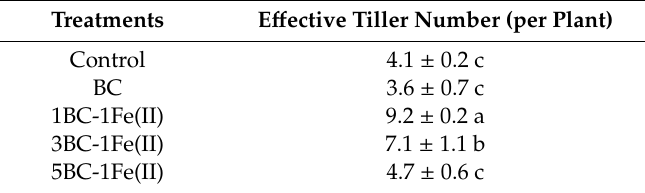
Figure 1. Growth of rice at the tillering stage. Table 2. Effective tiller number of per rice plant.